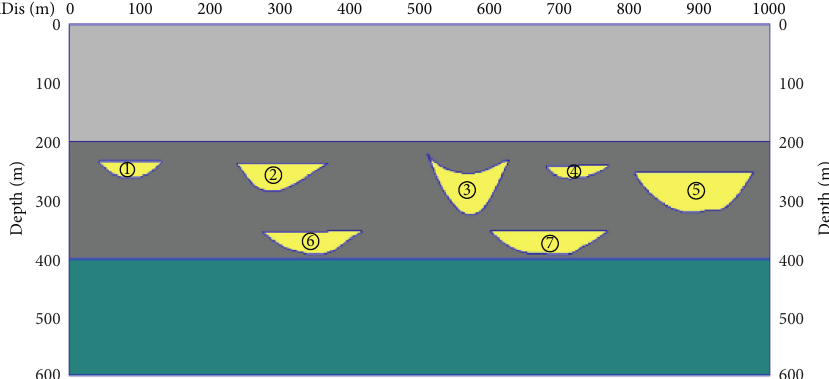
Figure 1: 2D channel geological model with noninterference.